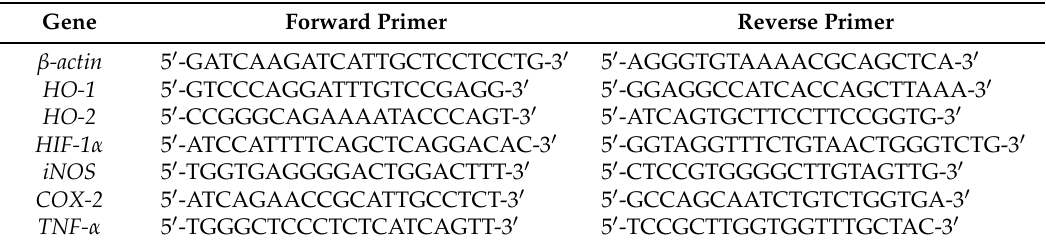
Table 1. Forward and reverse primers used in real-time PCR reaction to assess mRNA expression for β -actin, heme oxygenase (HO)-1, HO-2, hypoxia inducible factor 1 α (HIF-1 α ), inducible nitric oxide synthase (iNOS), cyclooxygenase (COX)-2 and tumor necrosis factor α (TNF- α